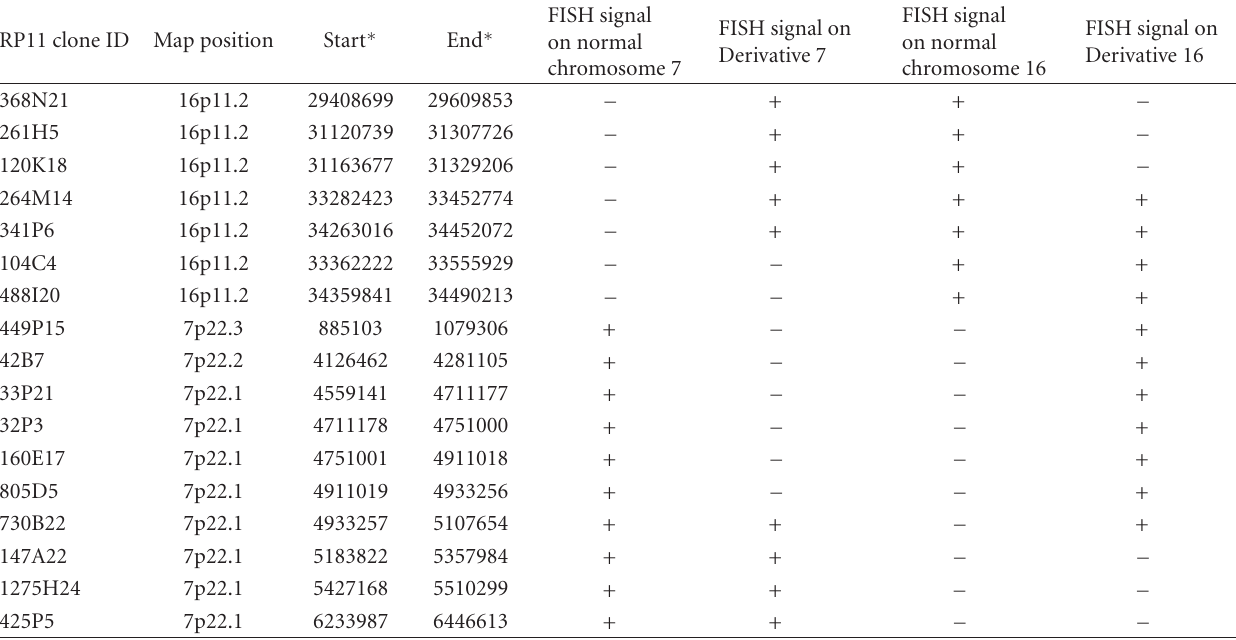
Table 1: FISH results using BAC clones on 7p and 16p regions.